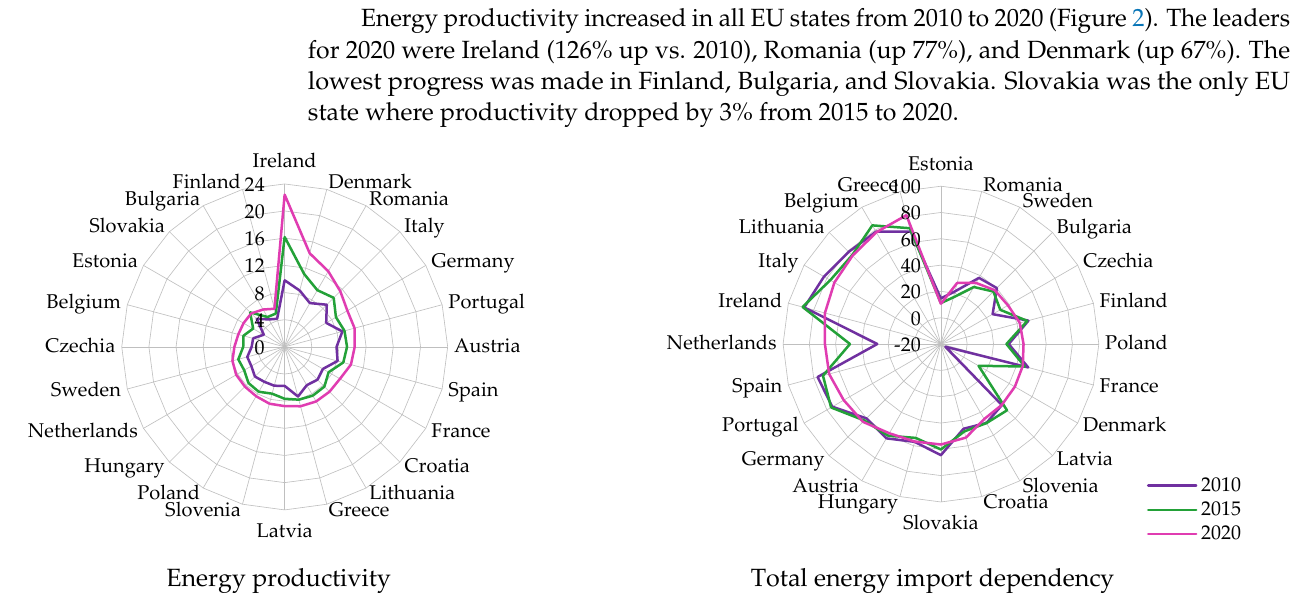
Figure 2. Values of energy productivity and energy import dependency in the years 2010–2020.